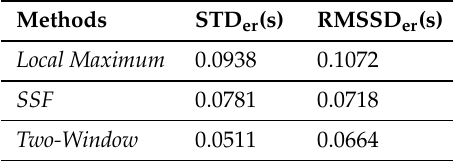
Table 4. The average errors of Pulse Rate Variability (PRV) features.